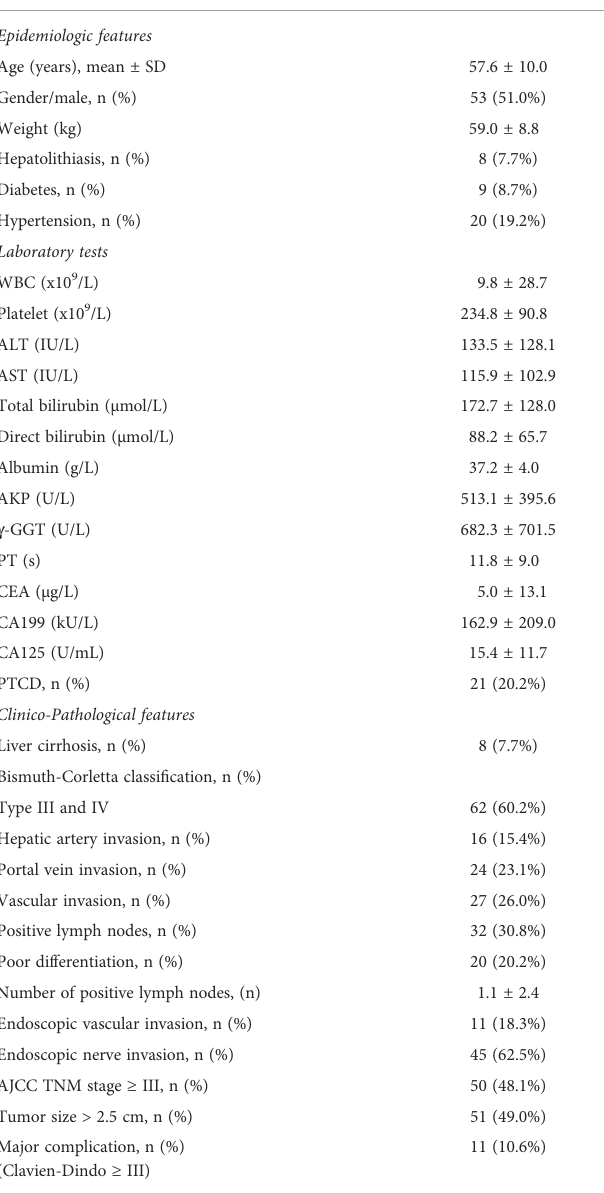
Serum elevated CA242 is an independent risk factor for vascular invasion and lymph node metastasis Univariable and multivariable analysis were conducted to investigate the relationship between serum CA242 and vascular invasion. The results were shown in Table 2, the elevated CA242 (OR=2.619, p=0.006) and Type III and IV Bismuth-Corletta classi fi cation (OR=2.816, P=0.001) were independent risk